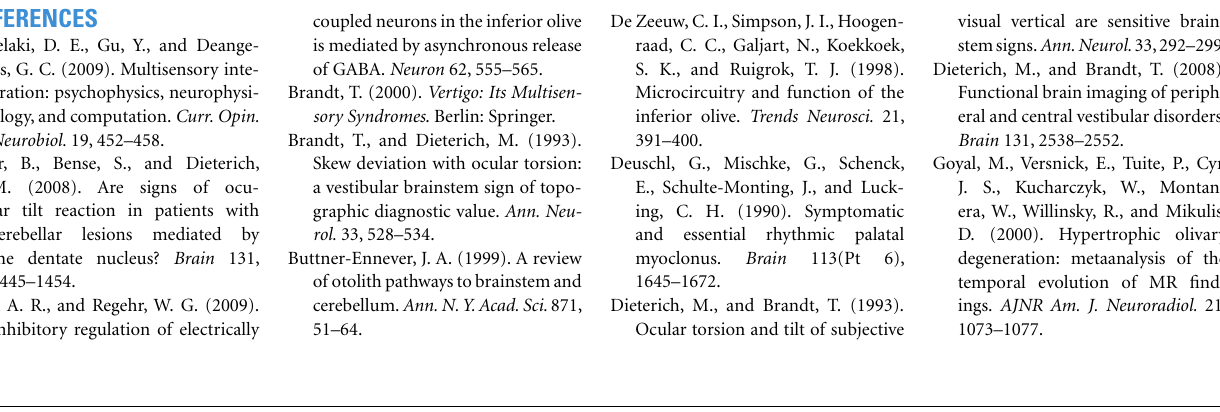
comparison the grand mean (black dots) ± 2 SD of SVV adjustments from seven healthy normal control subjects (data taken fromTarnutzer et al., 2009). This range covers about 95% of all values and is illustrated by the gray